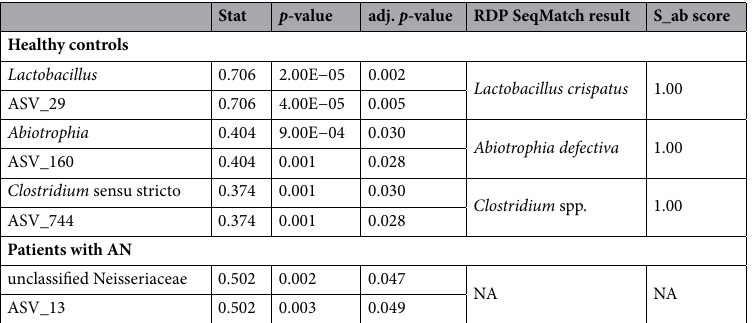
Figure 5. Spearman correlations between Shannon diversity index and ( a ) psoriasin concentrations, ( b ) psoriasin concentrations at individual sampling locations, ( c ) total bacterial load, and ( d ) total bacterial load at individual sampling locations. r(s) = spearman’s Rho. AN = anorexia nervosa. ns = not significant. Blue represents healthy-weight controls, red represents patients with AN before weight gain, and gold represents patients with AN after weight gain. p -values were adjusted for multiple testing according to Benjamini and Hochberg 94 . Stat p -value adj. p -value RDP SeqMatch result S_ab